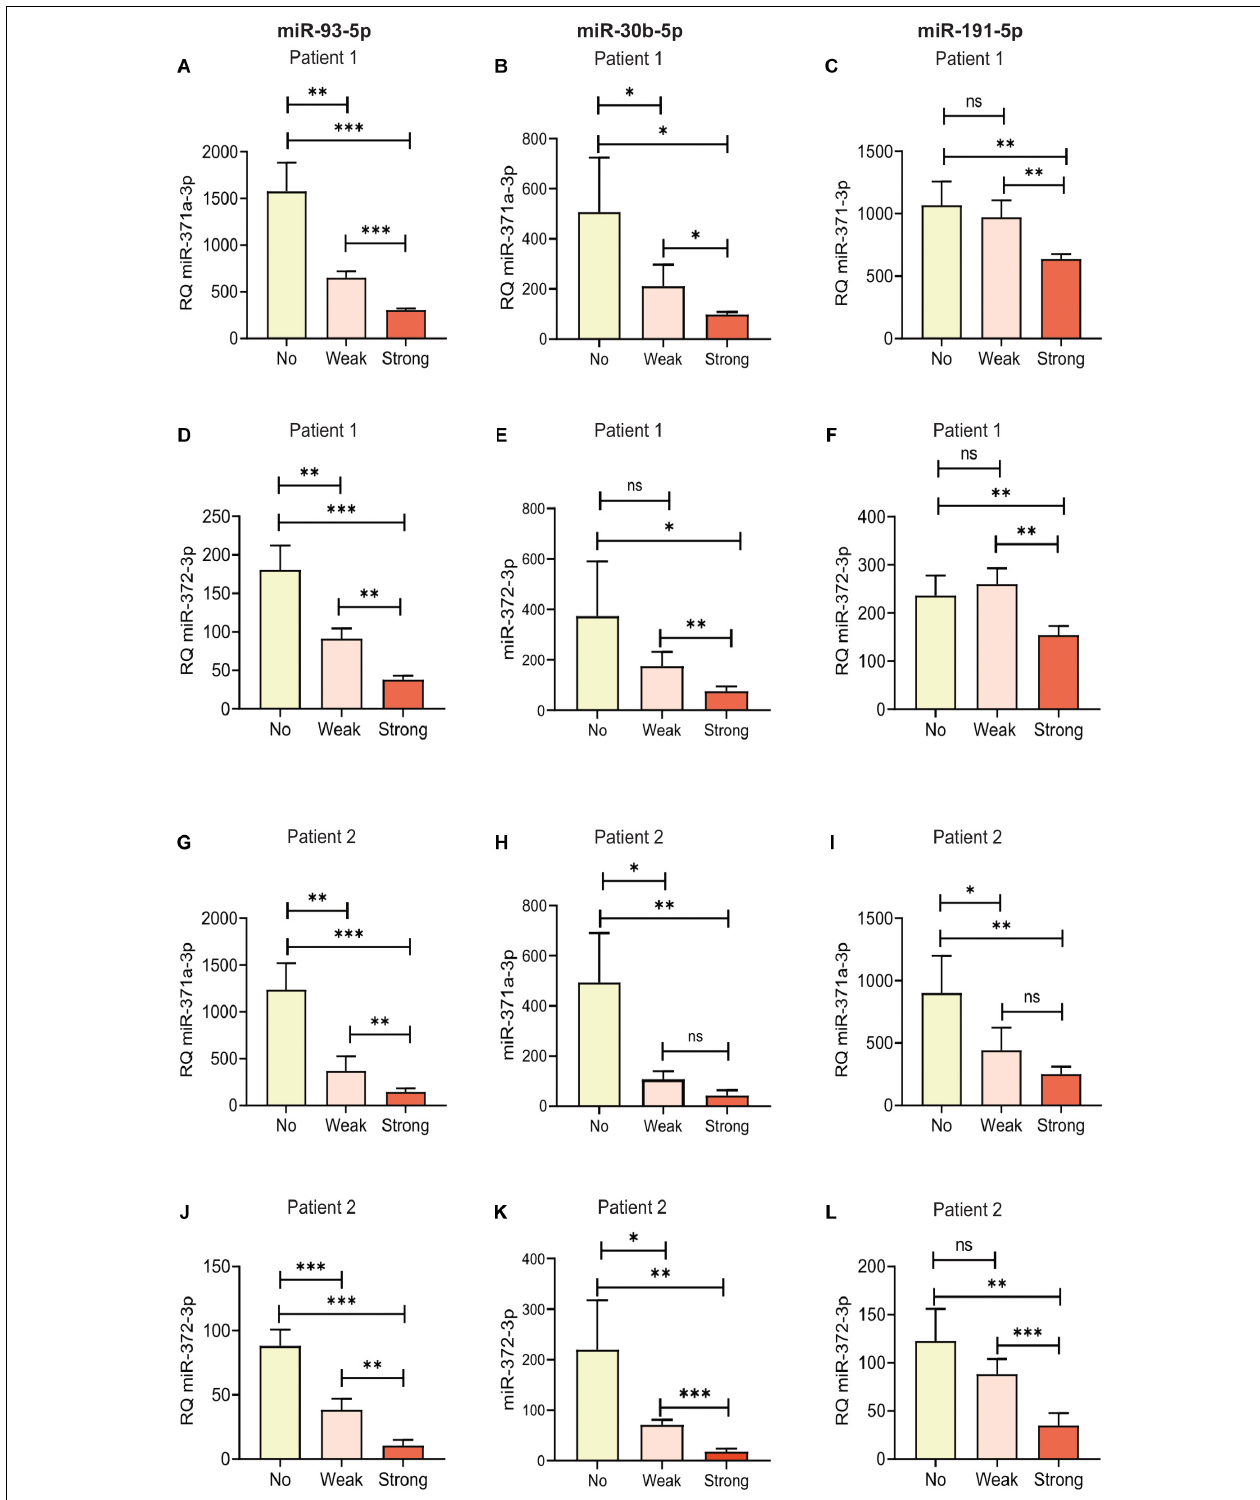
FIGURE 3 | Hemolysis affected the measured levels of specific microRNAs in serum from the two patients, Patient 1 and Patient 2. Relative quantities (RQs) representing miR-371a-3p and miR-372-3p were calculated with miR-93-5p (A,D,G,J) , miR-30b-5p (B,E,H,K) and miR-191-5p (C,F,I,L) as reference genes. “No,” “Weak,” and “Strong” represent the same serum, but with 0.0, 0.05, or 0.2% added RBCs, respectively. ∗ P < 0.05, ∗∗ P < 0.01, ∗∗∗ P < 0.001. Bars represent mean RQ with standard deviations (SD). RQ = 2 − (cid:49)(cid:49) Cq .